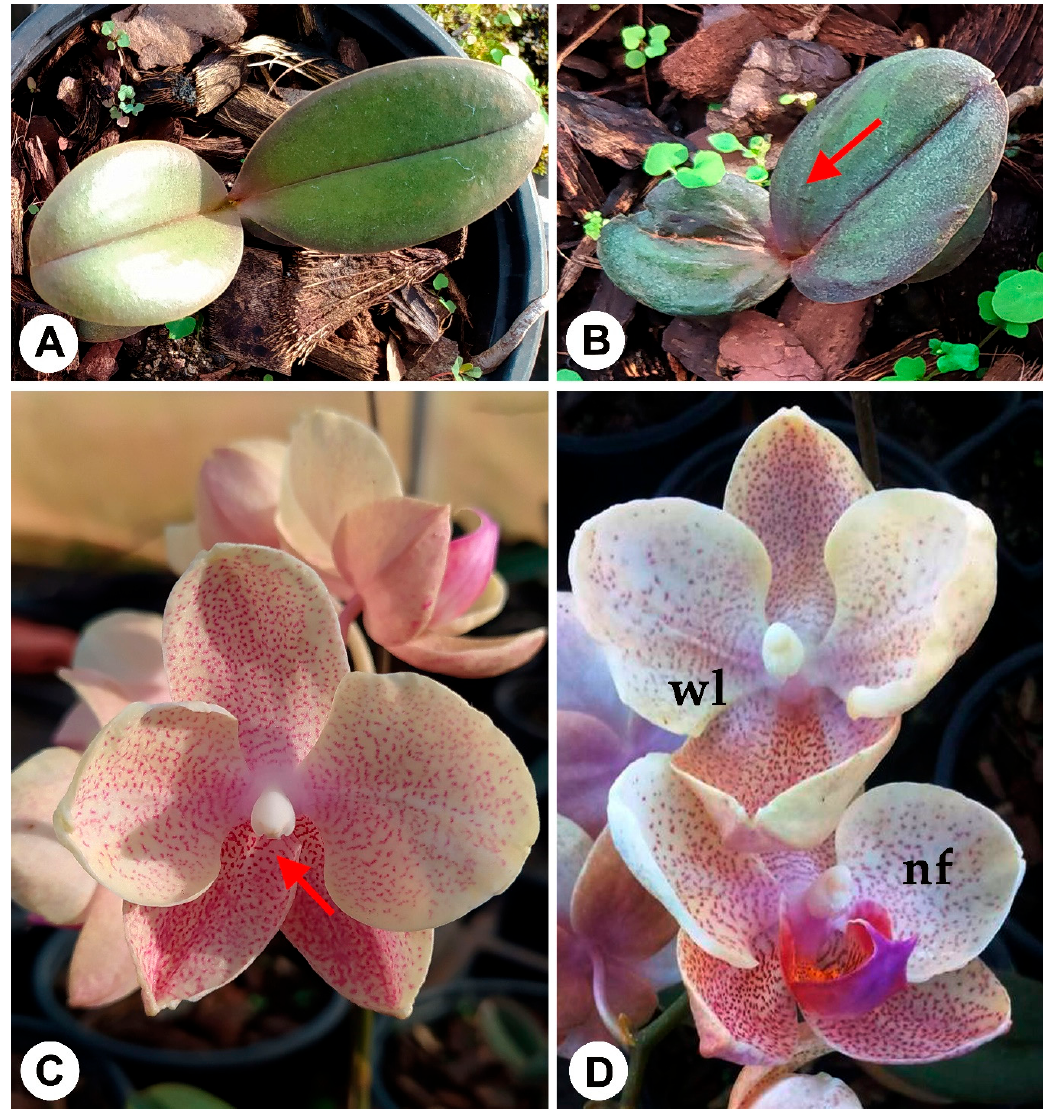
Figure 2. Somaclonal variations observed in Phalaenopsis induction, proliferation and regeneration of protocorm-like Bodies in Phalaenopsis Hybrid “908”. Normal vegetative developed plant ( A ) and somaclonal variation observed in vegetative development with “creased leaves” (red arrow) ( B ); ( C , D ), Normal vegetative developed plants with somaclonal variations in flower development, with first and last flower without of labellum (red arrow, wl) in the same inflorescence with normal flowers (nf). All figures are unpublished photos from J.C.C.